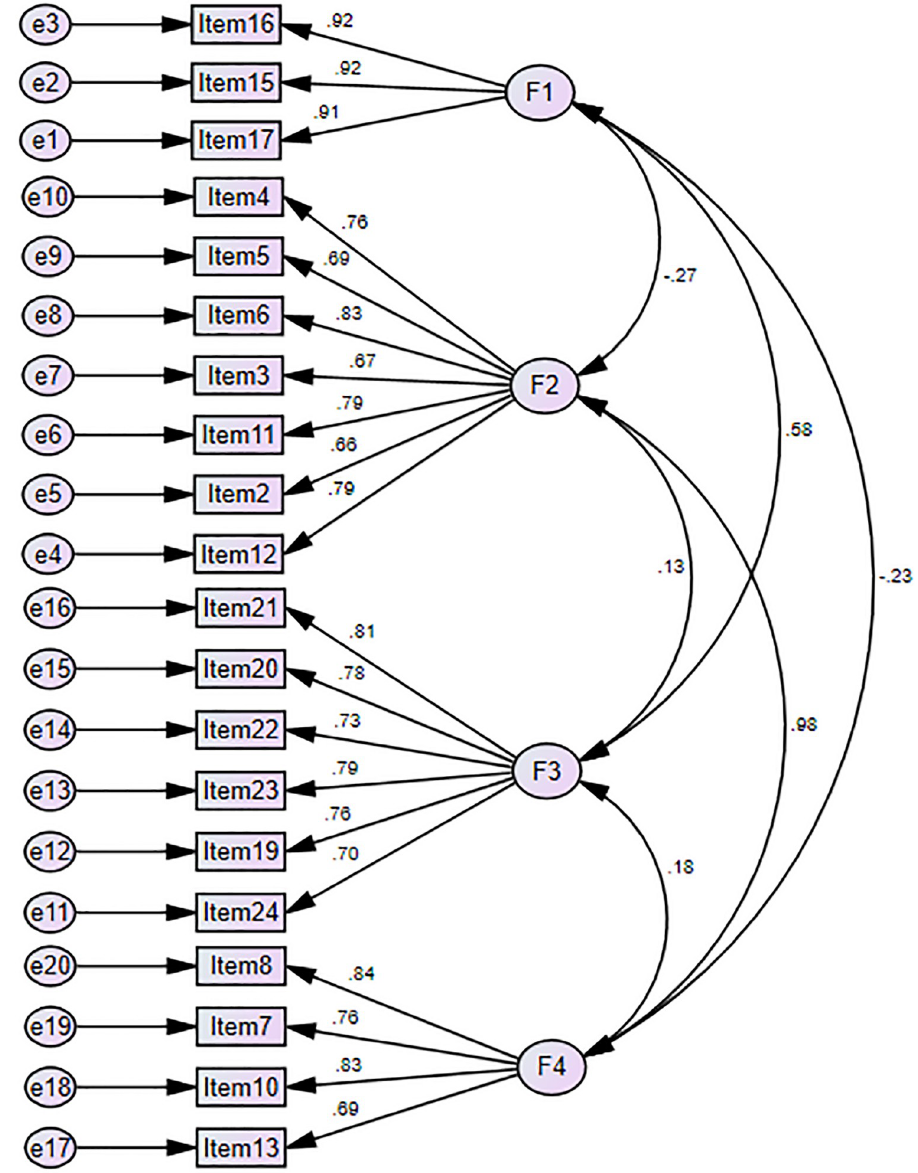
Fig 2. Measurement model for QPE. Note: Factor 1- Core Values of Quality Physical Education (CVPE), Factor 2- Development of Supportive Elements for Quality Physical Education in School (DSFQPE), Factor 3- Provision and Norms in Physical Education (CAPA), and Factor 4- Provision and Norms in Physical Education (PNPE).